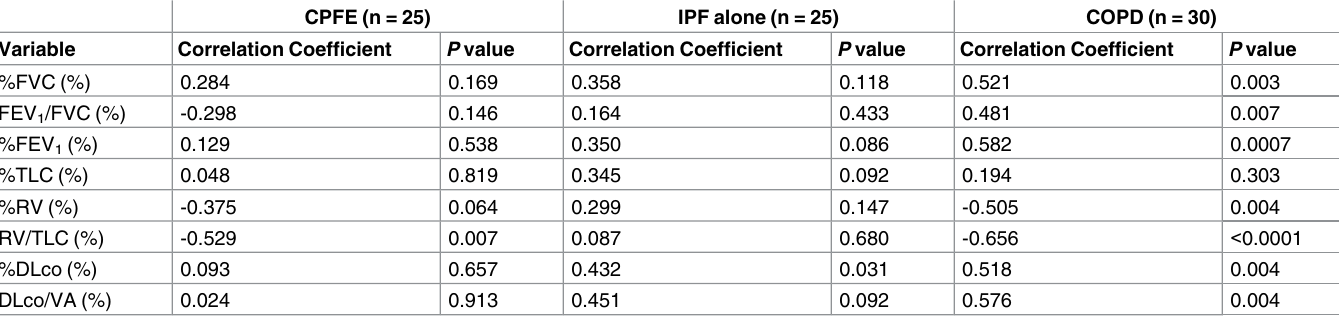
Table 3. Correlation coefficients for relationships between the percentage of areas enhanced by Xenon and pulmonary function parameters in CPFE patients (n = 25), IPF alone (n = 25), and COPD (n = 30).